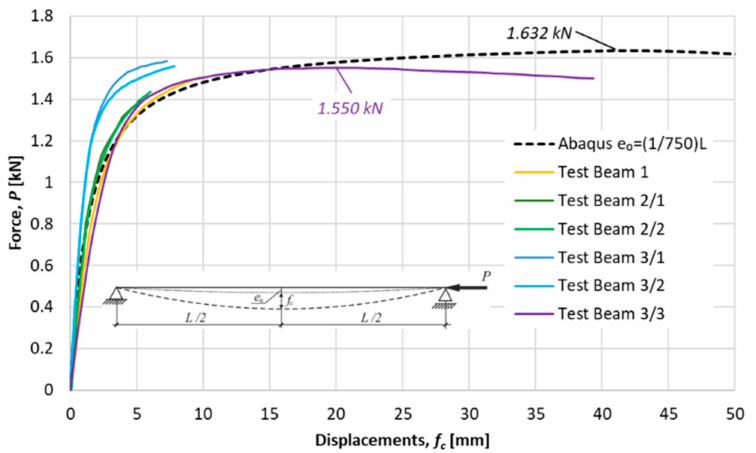
Figure 14. Specimen L = 1057.1 mm. Load deflection paths obtained in experimental tests and numerically.